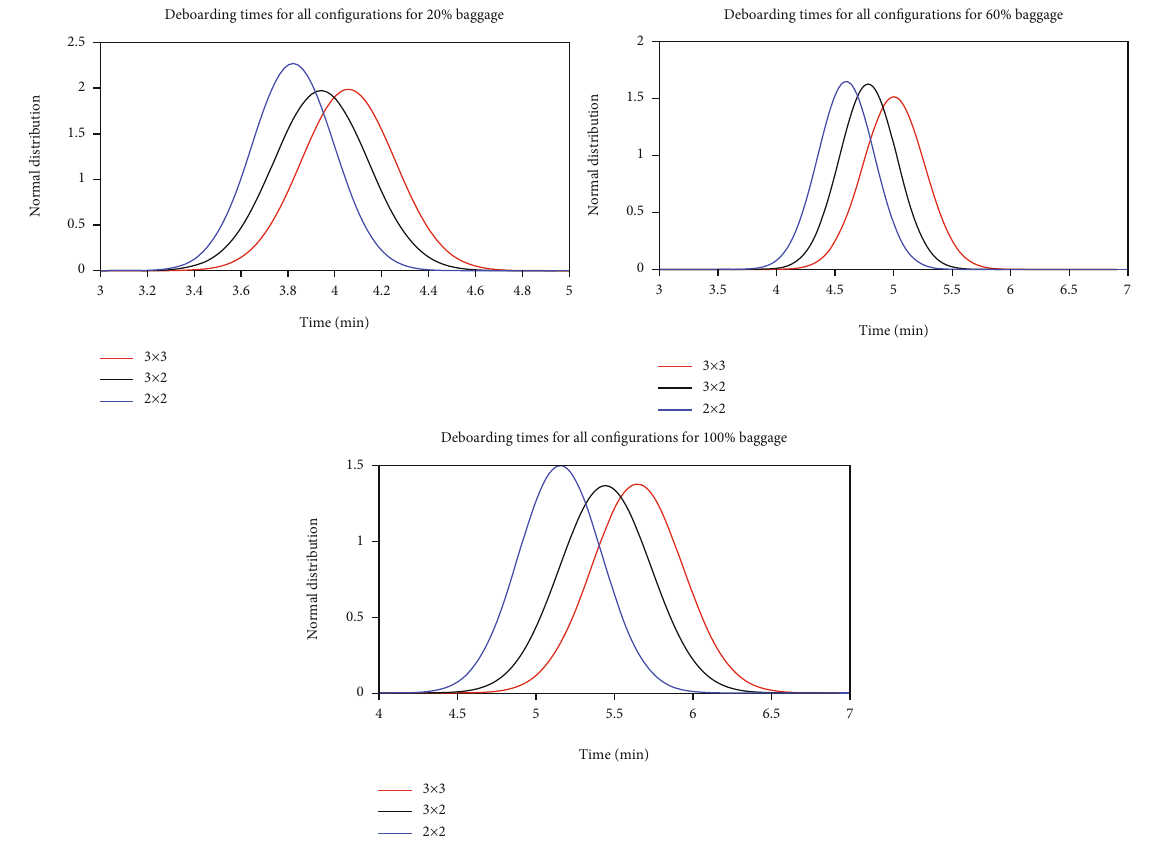
Figure 16: Fitted normal distribution curves for deboarding for each aircraft con fi guration for di ff erent % of baggage. Table 11: Complete comparison of deboarding times for the three aircraft con fi gurations for di ff erent % of carry-on baggage. Times (min:sec) for % carry-on baggage Con fi